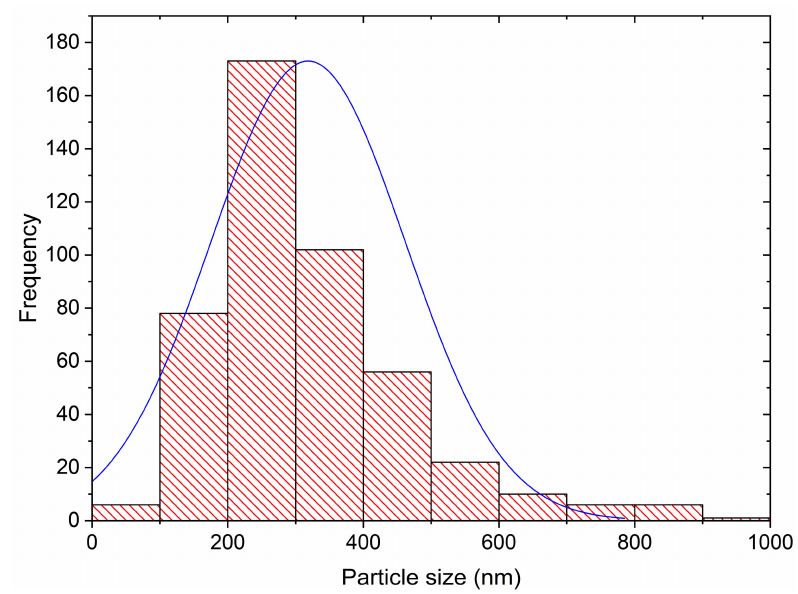
Figure 3. Histogram of the size of the iron-rich nanostructures present on the GSP-Fe surface. – Normal distribution curve.